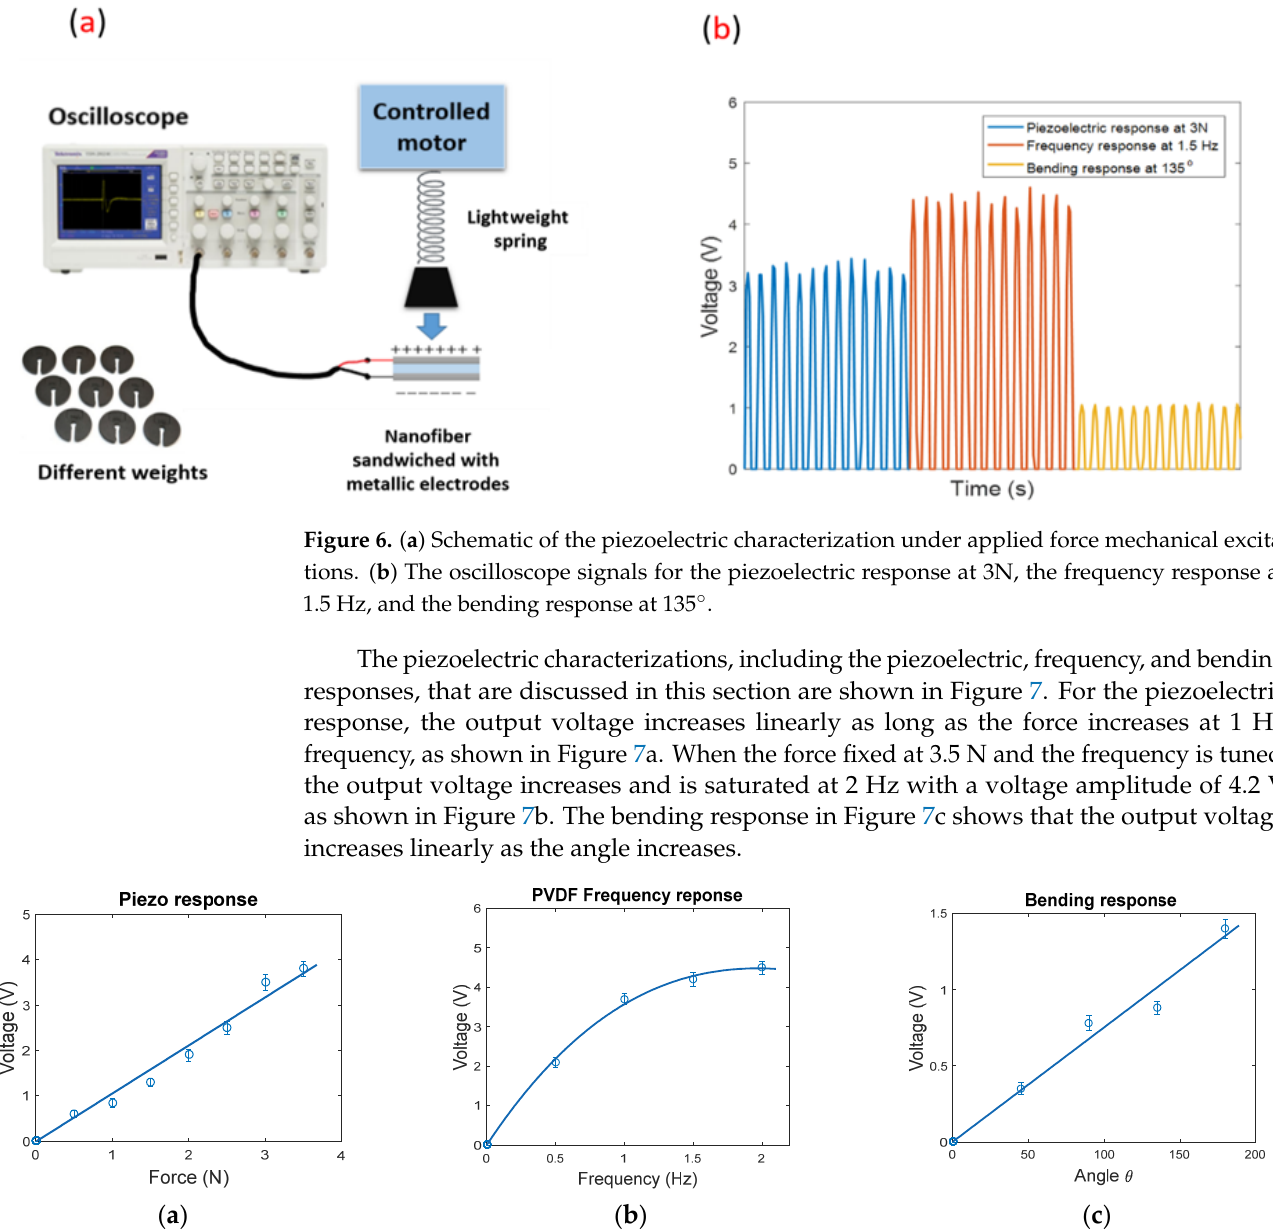
Figure 7. The Piezoelectric ( a ), frequency ( b ), and bending ( c ) response characterizations of the PVDF electrospun nanofibers.